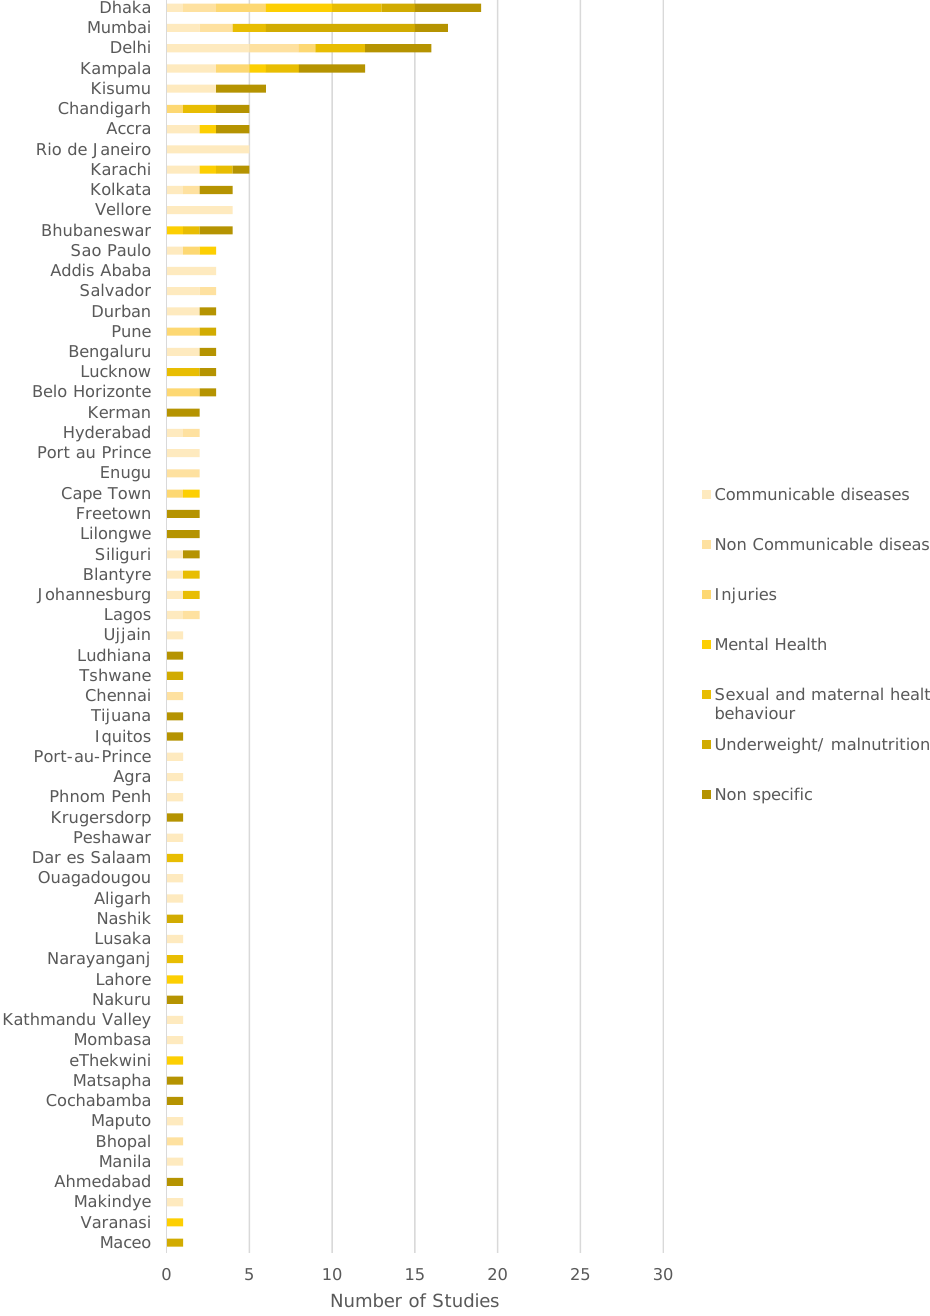
Figure A2. This figure shows the number of studies per city on city scale. The colors label the health categories of the